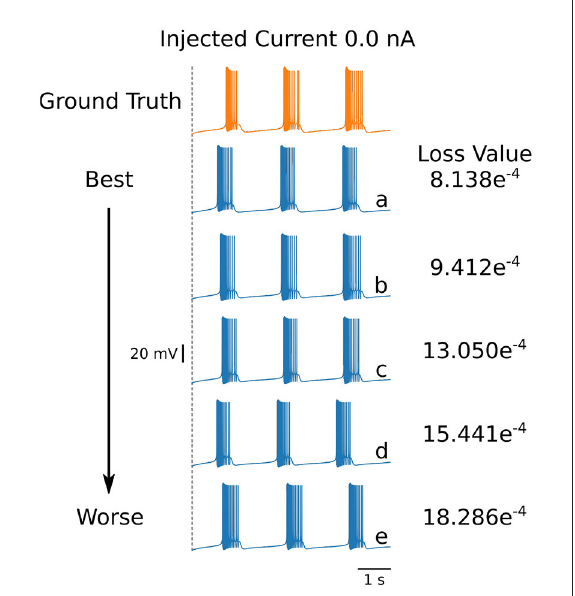
FIGURE6 First 5 solutions for the injected current of 0 nA. These solutions are ranked from “best” to “worse” (A–E) according to their loss. Even a nearly-identical loss can produce a qualitatively different voltage trace, as shown by traces (D,E) . The values for the parameters sets for each of the voltage traces can be found in Table